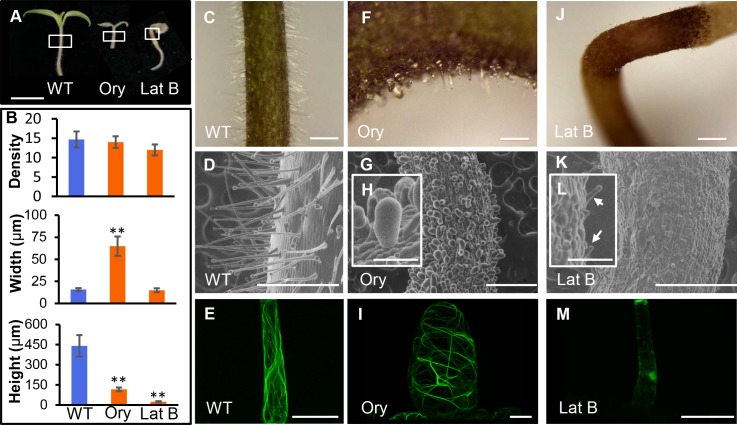
Effect of pharmacological disruption of microtubules and actin filaments on trichomes.(A) The seedling phenotype after four-day treatment with Oryzalin (Ory) and Latrunculin B (Lat B). (B) Disruption of microtubules and actin filaments dramatically changed the trichome morphology but did not inhibit trichome initiation (Statistic analysis of the trichomes density of over 100 hundred epidermal cells for each treatment). (C-E) Trichome morphology and Lifeact-eGFP in WT trichomes. (F-I) Treatment with Ory resulted in isotropically expanded cells (G, H) and horizontal actin bundles (I). (J-M) Treatment with Lat B caused the entire depolymerization of actin filaments (M) and decreased cell elongation (K, L). (D, G, J) are SEM micrographs and (E H K) are confocal images. A, Bar: 1 cm. C and I, Bar: 500 μm. F, Bar: 250 μm. D, G and J, Bar: 500 μm. E, H and K, Bar: 50 μm. H and L, Bar: 100 μm.